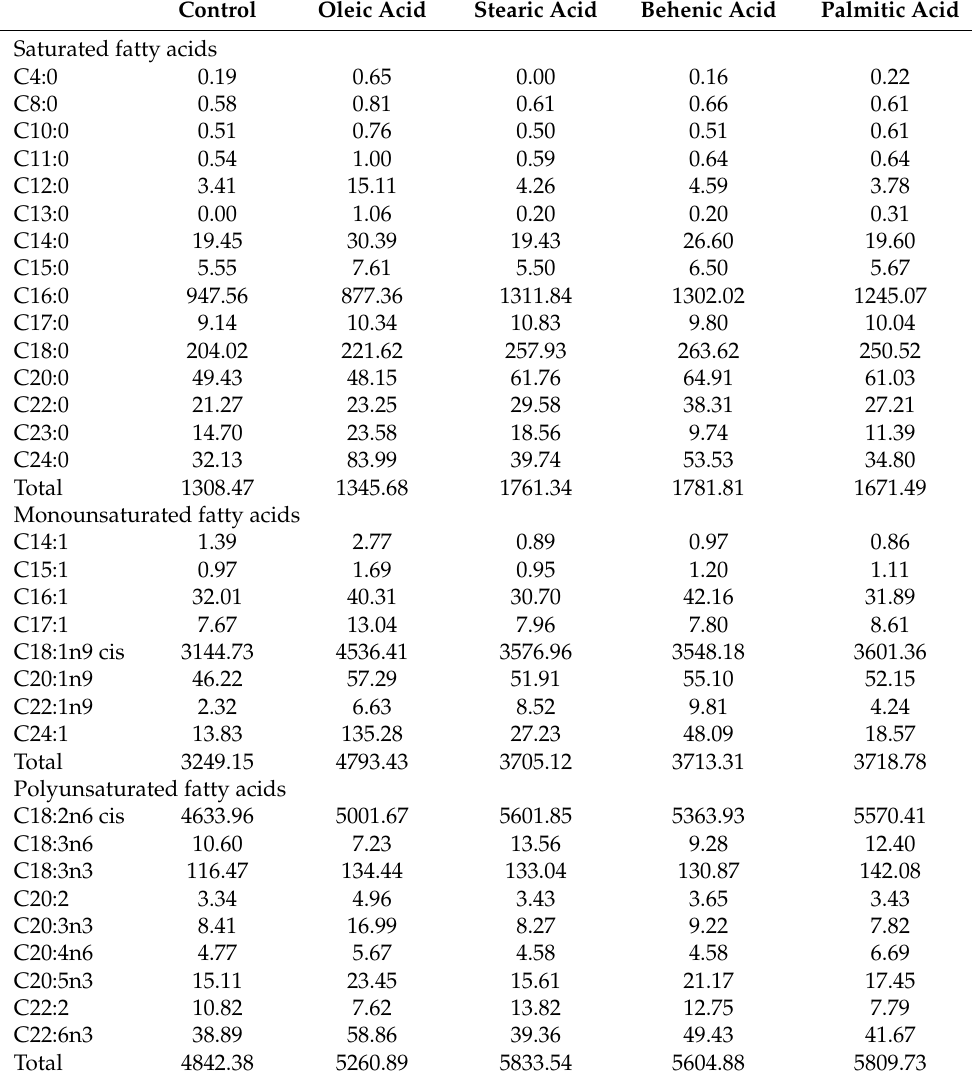
Table 2. Fatty acid (mg/100 g on dry matter basis) profile of the formulated experimental diets. Control Oleic Acid Stearic Acid Behenic